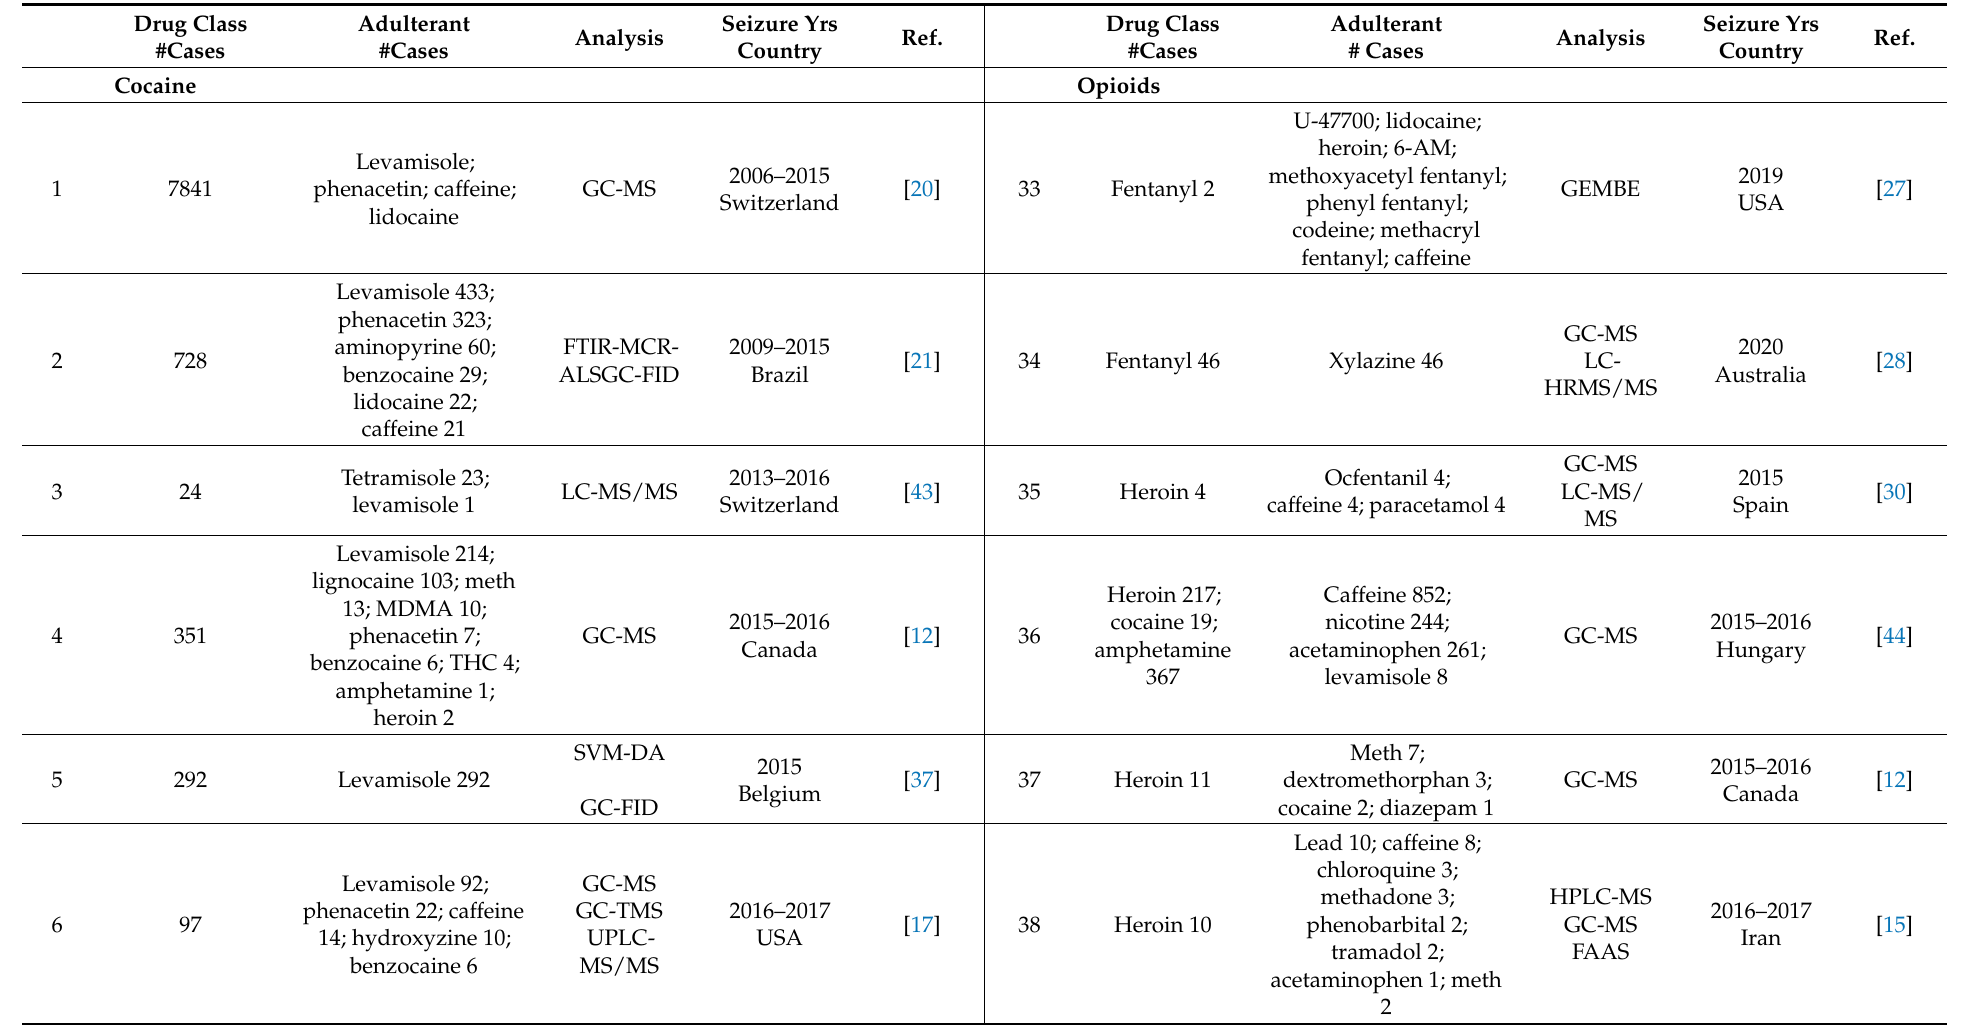
Table 1. Adulterants detected in seized samples of cocaine, opioids, amphetamine-type stimulants, and new psychoactive substances (NPS) reported in the literature between 2017 and